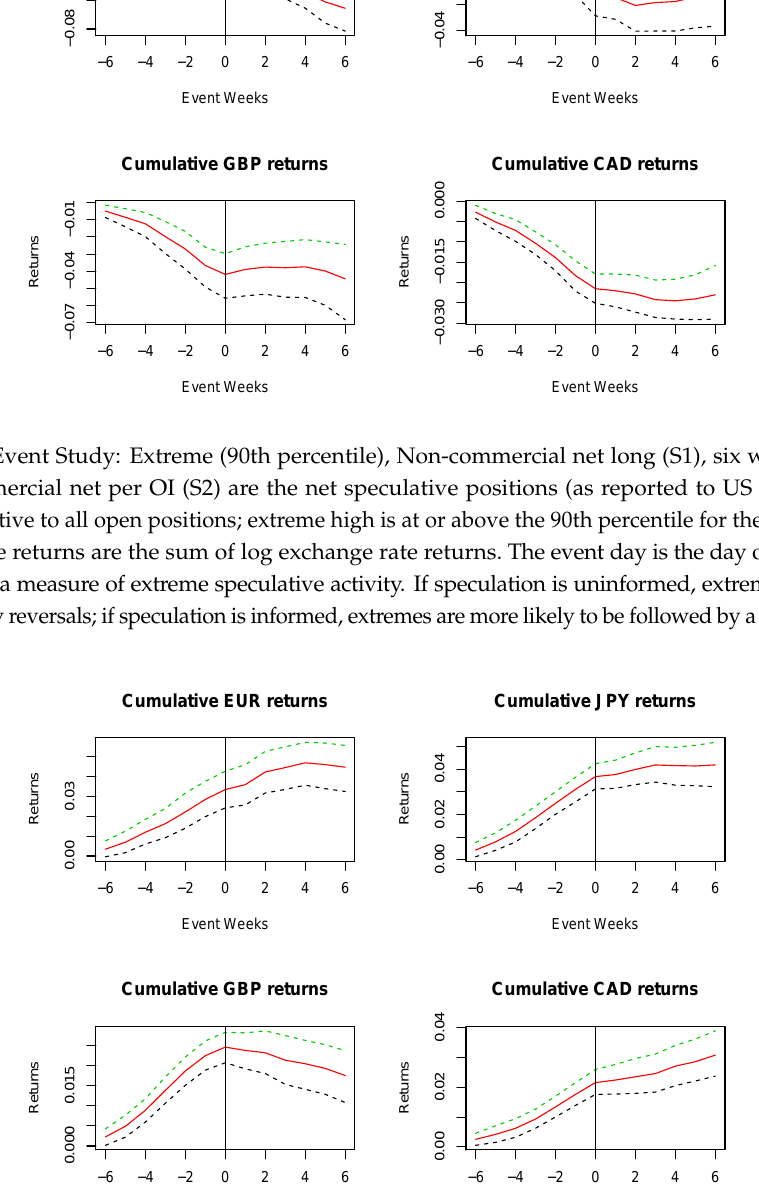
Figure 4. Event Study: Extreme (90th percentile), Non-commercial net long (S1), 6 week window. Non-commercial net per OI (S2) are the net speculative positions (as reported to US regulator the CFTC) relative to all open positions; extreme high is at or above the 90th percentile for the whole range, cumulative returns are the sum of log exchange rate returns. The event day is the day of the extreme reading as a measure of extreme speculative activity. If speculation is uninformed, extremes should be followed by reversals; if speculation is informed, extremes are more likely to be followed by a random